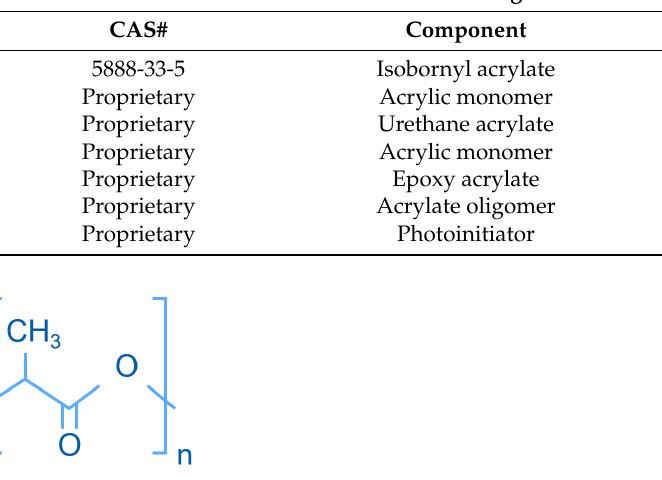
Figure 2. Structural model of PLA material [48].